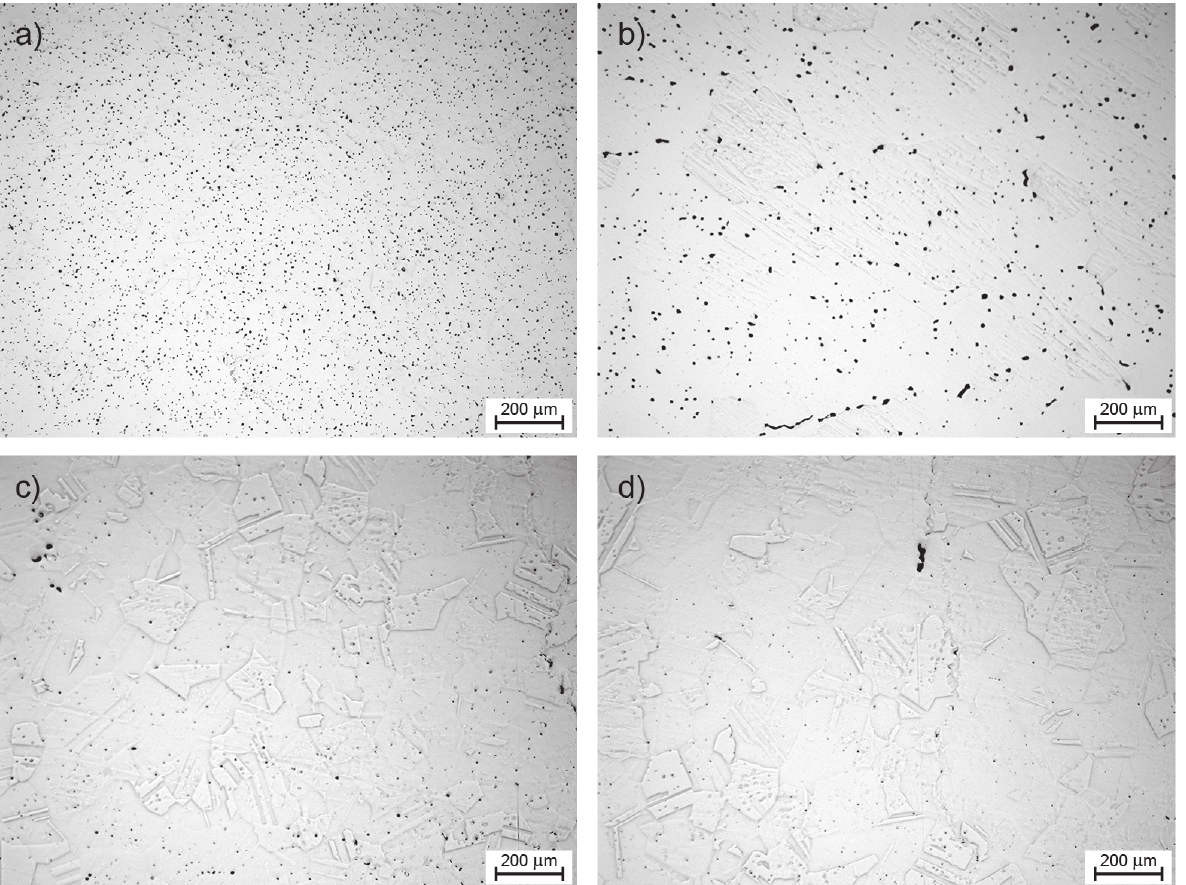
Figure 9. Optical micrographs of samples sintered at 1325 °C under N 2 -10%H 2 -0.1%CH 4 atmosphere for sintering times